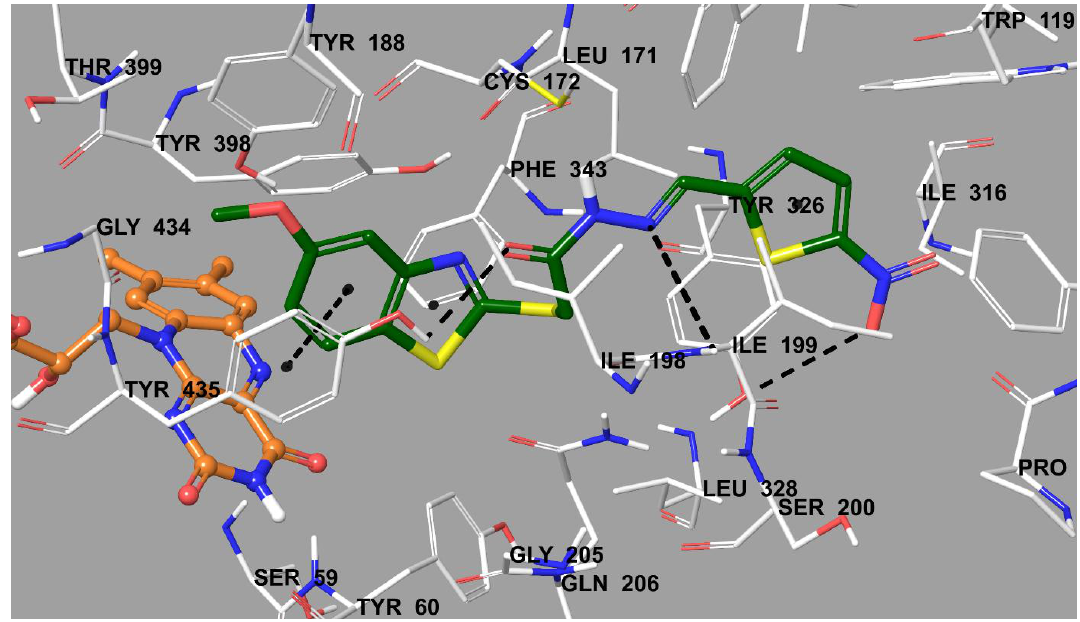
Figure 3. The interacting mode of compound 3e in the active region of h MAO-B. The inhibitor and the important residues in the active site of the enzyme are presented as a tube model. The FAD molecule is colored orange as ball and stick models.